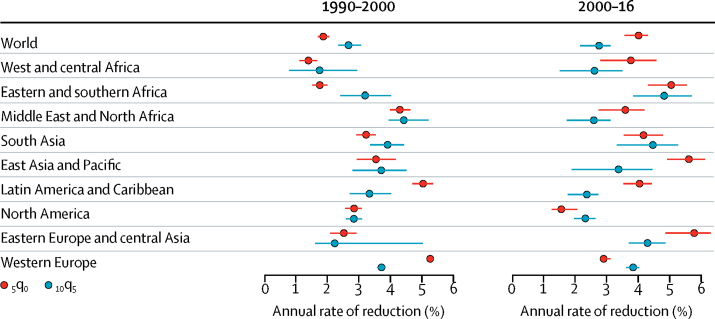
Comparison of the annual rate of reduction in 5q0 and 10q5 in 1990–2000 and 2000–16, by region5q0 is the probability of dying before age 5 years, and 10q5 is the probability of dying between ages 5 years and 15 years.